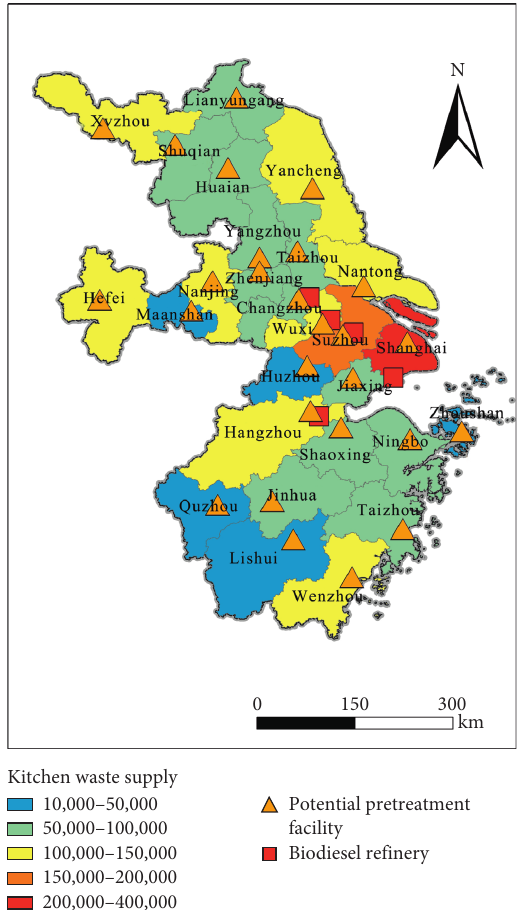
Figure 4: Location of alternative points of pretreatment